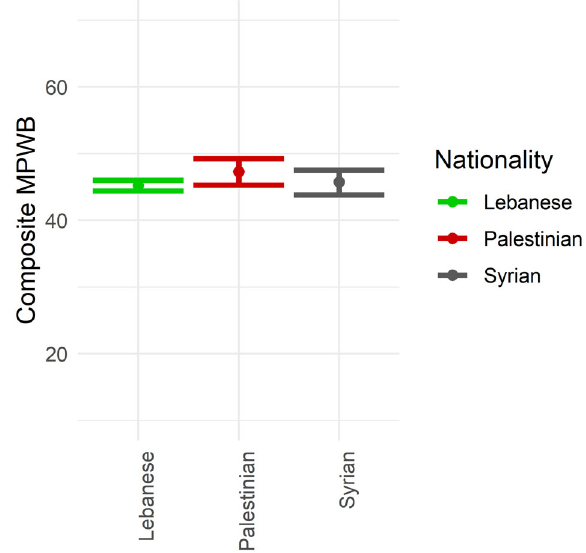
Fig. 3 Mean total MPWB by nationality, error bars show bootstrapped con fi dence intervals. The composite well-being scores show no signi fi cant differences between any of the three groups. The Y -axis represents the full range of possible values, which is presented intentionally to indicate that in spite of a wide range of possible outcomes, the three group means are generally